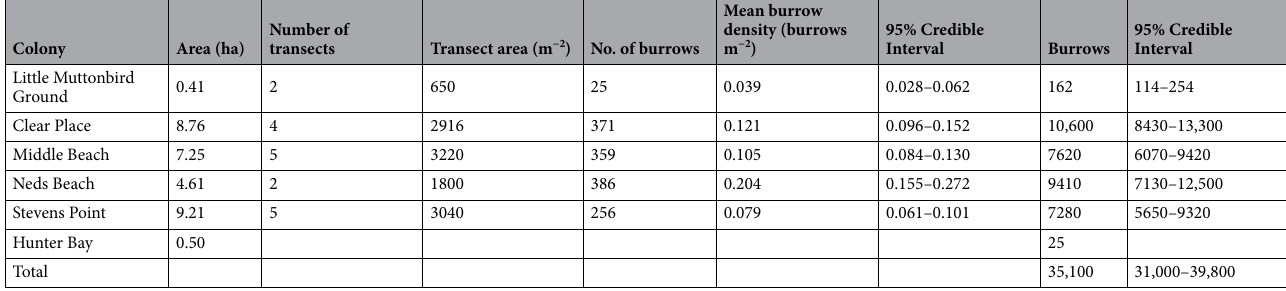
Table 1. Area, estimated flesh-footed shearwater burrow density (burrows m −2 ) and number of burrows and 95% Credible Interval for each colony on Lord Howe Island, 2014/15. Note all burrows were counted at Hunter